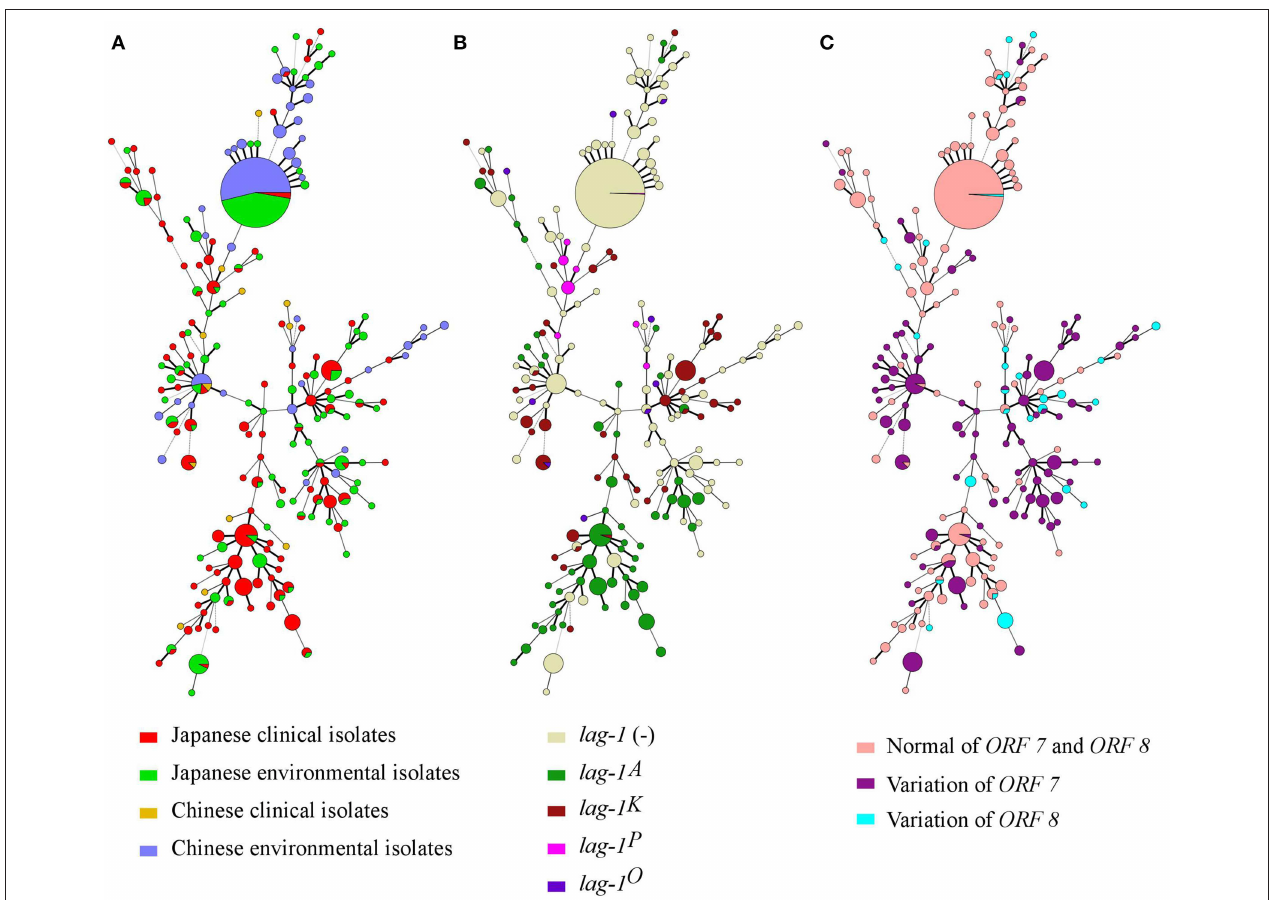
FIGURE 2 | Minimum spanning tree analysis of 616 L. pneumophila serogroup 1 strains isolated in Japan and China. STs are shown as circles. The size of each circle indicates the number of isolates within this particular type. The 616 L. pneumophila serogroup 1 strains were divided into groups by countries and sources (A) , lag-1 alleles (B) , and Distribution of ORF 7 and ORF 8 genes of LPS (C)